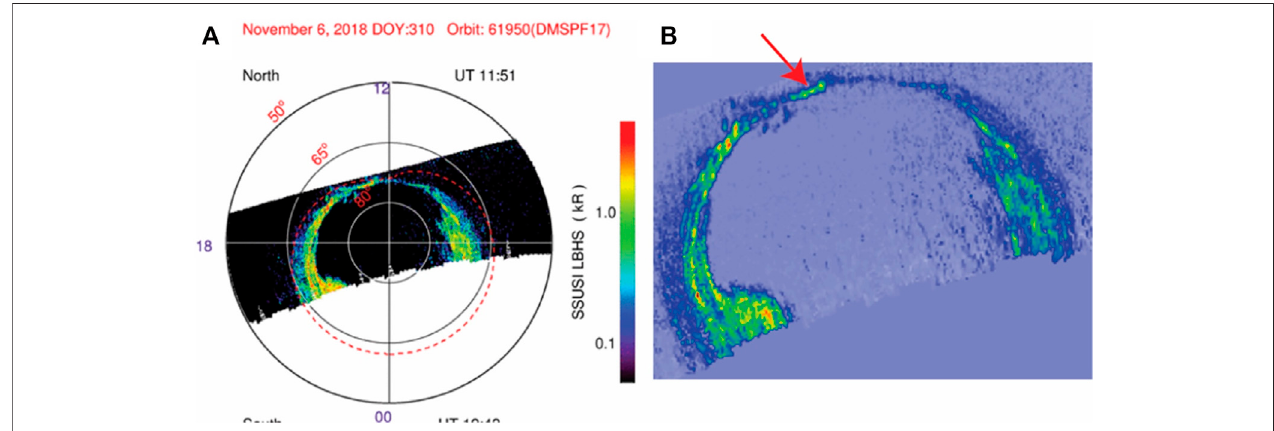
FIGURE10|(A) DMSPSSUSILBHSimage oftheauroral bead on2018-11-06 11:40 – 12:00UT. (B) Azoomed inversion ofauroralemissionsshown inpanel (A) . The red arrow shows the bead that is analyzed in DMSP Observations of a Dayside Ionosphere “ Bead ”